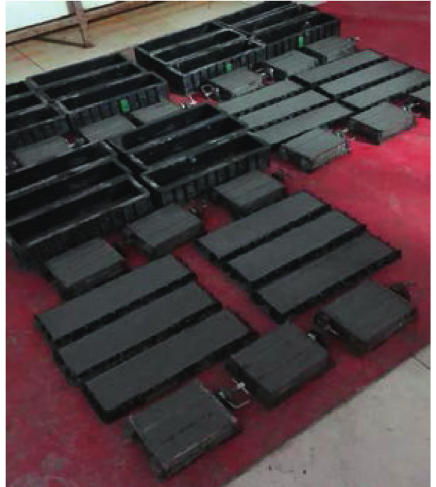
Figure 2: Types of specimens produced.